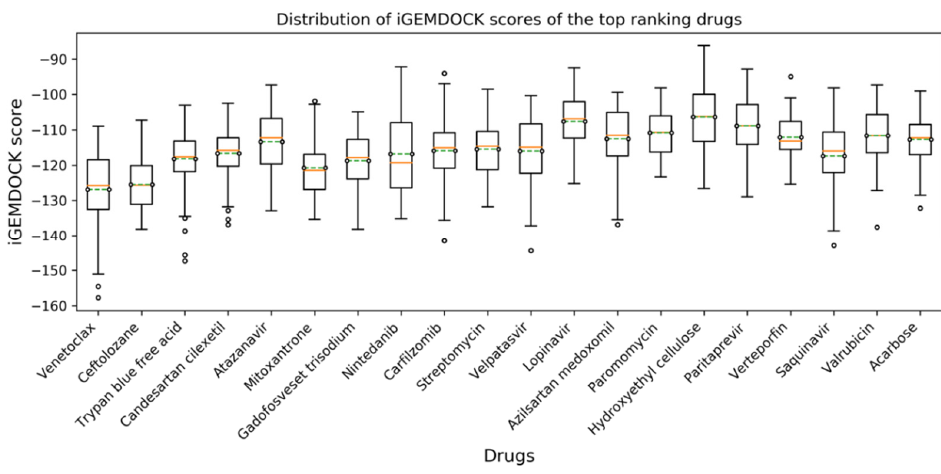
Figure 2. Distribution of iGEMDOCK scores of the top 20 candidates, where a more negative value implies a greater interaction stability.